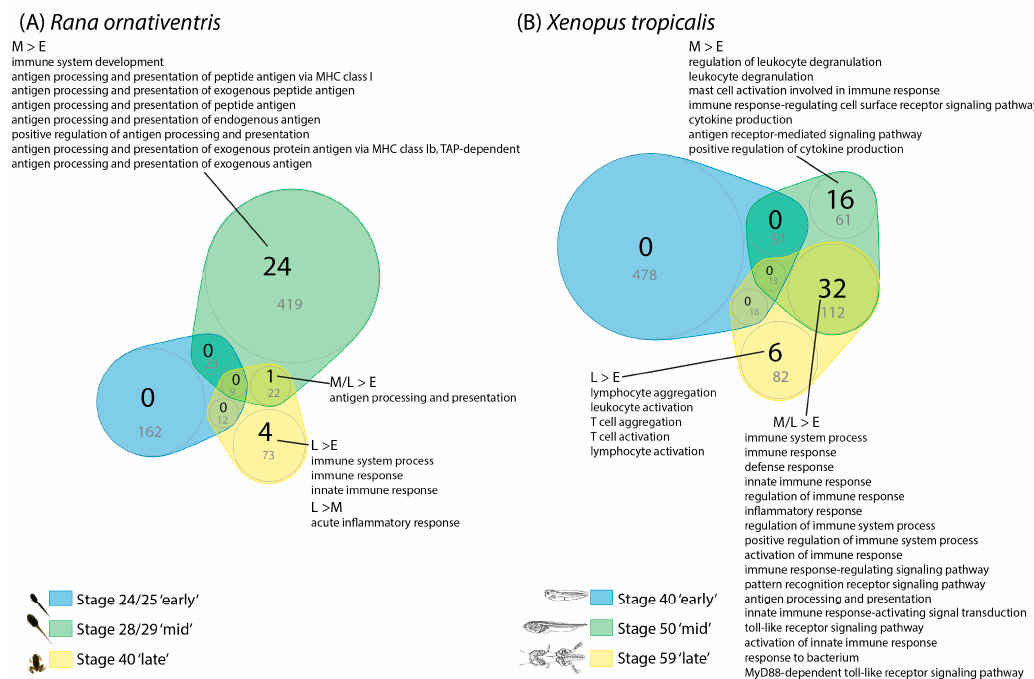
Figure 3. Venn diagrams of gene ontology (GO) terms enriched in skin of early- (E), mid- (M) and late- (L) larval stages from ( A ) Rana ornativentris and ( B ) Xenopus tropicalis . Number of immune-related enriched GO terms are in black (full list in Tables S5 and S6), and total number of enriched GO terms belonging to the ‘biological process’ parent category are in grey and also represented by circle sizes. Examples of enriched immune-related GO terms are listed in comparisons between stages (full list in Tables S5 and S6).